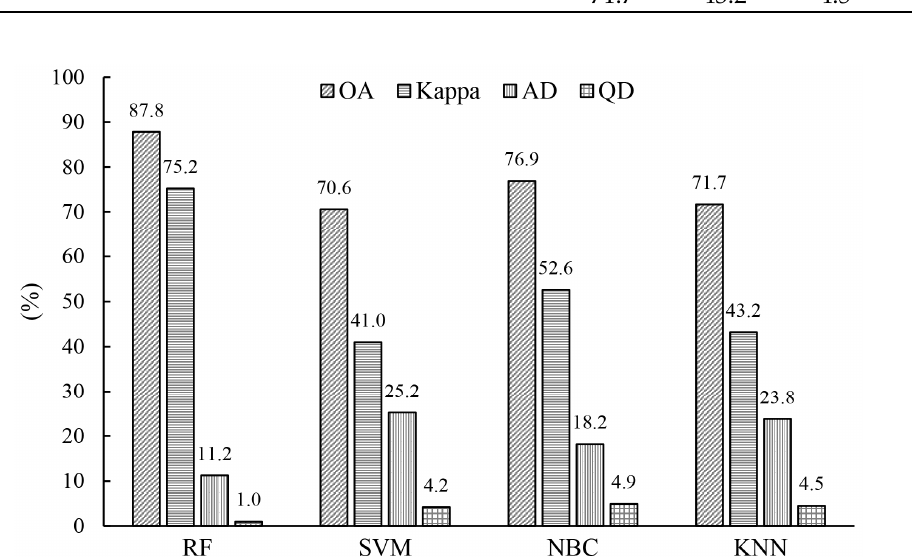
Figure 8. Accuracy comparison for the four algorithms.